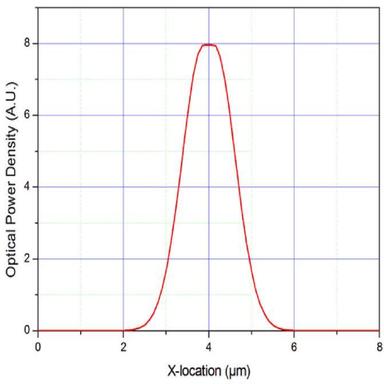
Optical power density lateral profile extracted from simulation at device surface. The x-axis is given in micrometer. The present profile is centered at 4 μm.